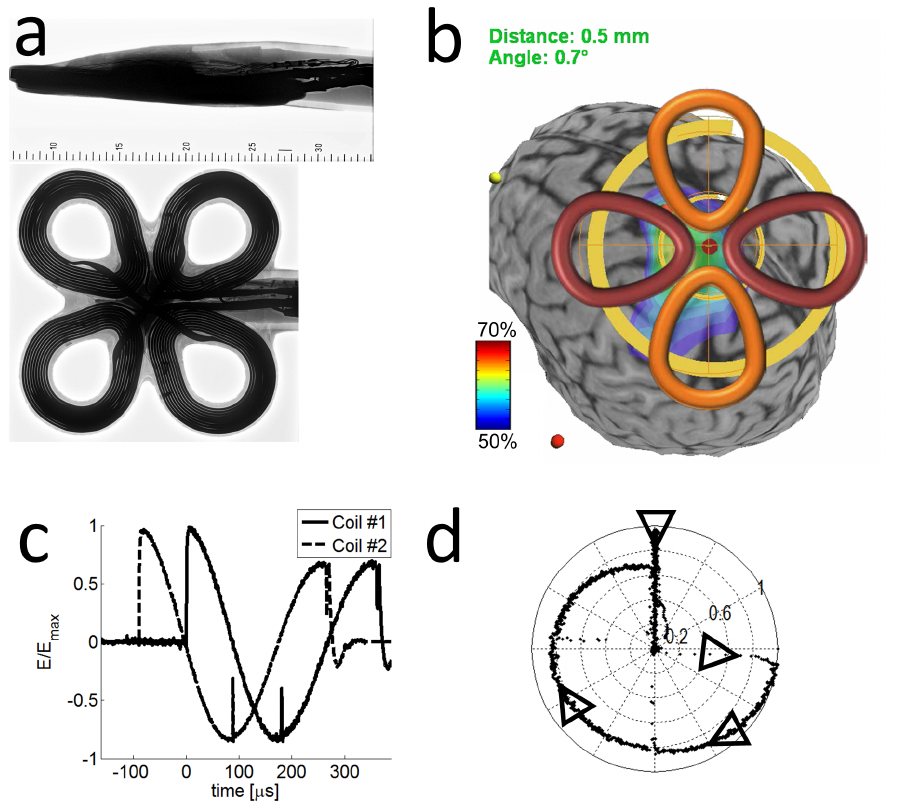
Figure 3. Cloverleaf coil experiment. a) Bottom and side X-ray images of the cloverleaf coil used in the experiment. The coils are coupled diagonally to form two figure of eight coils and each figure eight coil is connected to an independent power source. b) Neuro navigation software display. The position of the coil is tracked using the navigator and indicated by the central red dot and the yellow circle over an MRI scan of the brain of the subject. The coil shape is added offline to illustrate the actual position. The yellow sphere at the front is the nasion, the red sphere at the bottom left the left tragus, used in registering MRI and head position. The color scale indicates tentative field strength, calculated in real time assuming a spherical head model and a figure of eight coil. c) Electric field induced in a pickup coil positioned on 2 neighboring wings of the clover leaf coil. The coils were driven separately by 2 Magstim rapid 2 stimulators. d) A reconstruction of the effective electric field amplitude and direction during a rfTMS pulse of the clover leaf coil with the field of coil # 1 directed along the x-axis and the field of coil # 2 along the